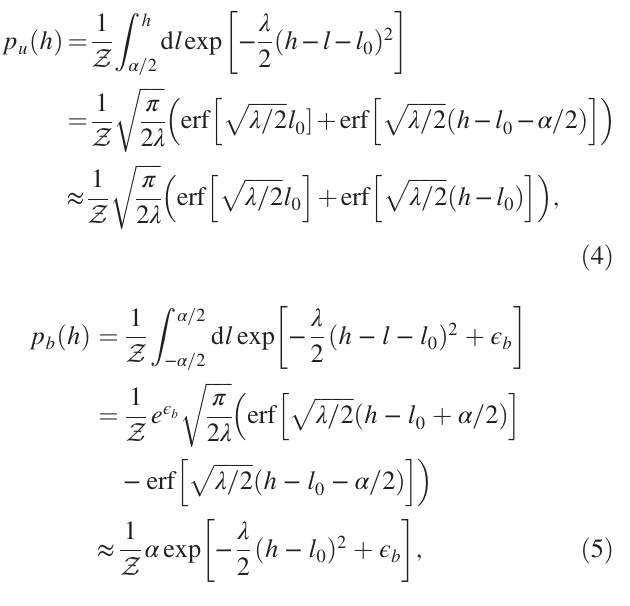
FIG. 3. Schematic representation of the model. (a) A receptor (spring) anchored to the membrane and the ligand (red circle) on the target surface. The surface and the membrane are separated by an instantaneous distance h ð t Þ , which determines the binding rate k ð h Þ and the unbinding rate k ð h Þ . (b) The model interaction on off potential (dashed line) between the ligand and the receptor. It consists of a harmonic potential centered at the position of the receptor ’ s rest length h − l 0 , shifted by a square well potential of width α and depth ϵ b centered at the surface with the ligand. The red shaded area denotes the bound receptor state, while the blue shaded area denotes the unbound receptor